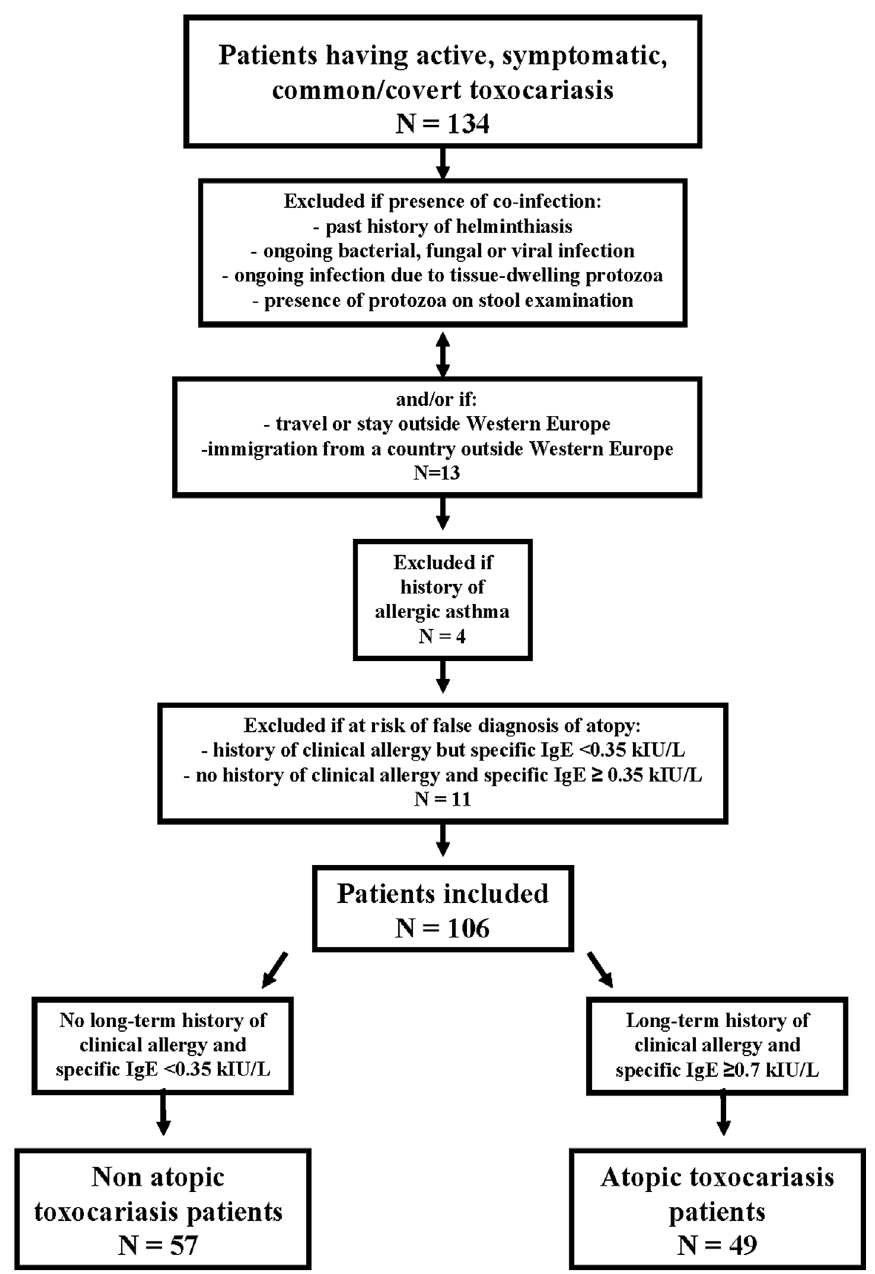
Figure 1. Flowchart of the selection process of 106 toxocariasis